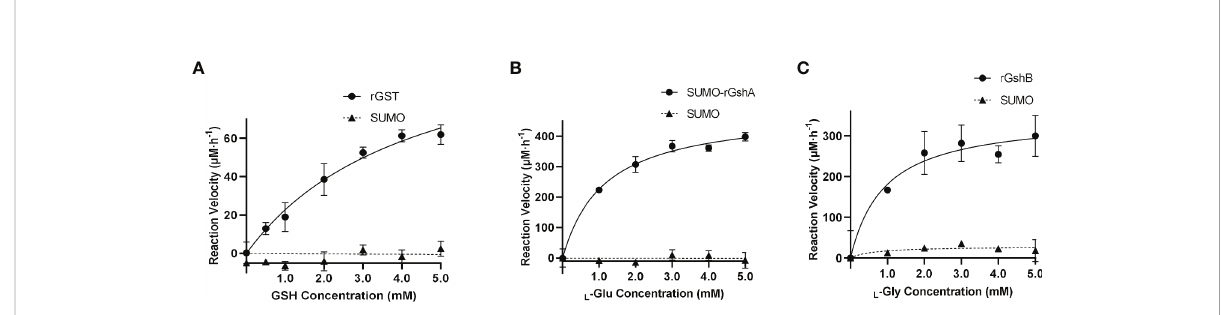
FIGURE 3 E. chaffeensis GST, GshA and GshB are functional in vitro . (A) Michaelis-Menten plot of rGST reaction velocity versus GSH concentration. (B) Michaelis-Menten plot of SUMO-rGshA reaction velocity versus L -Glu concentration. (C) Michaelis-Menten plot of rGshB reaction velocity versus L -Gly